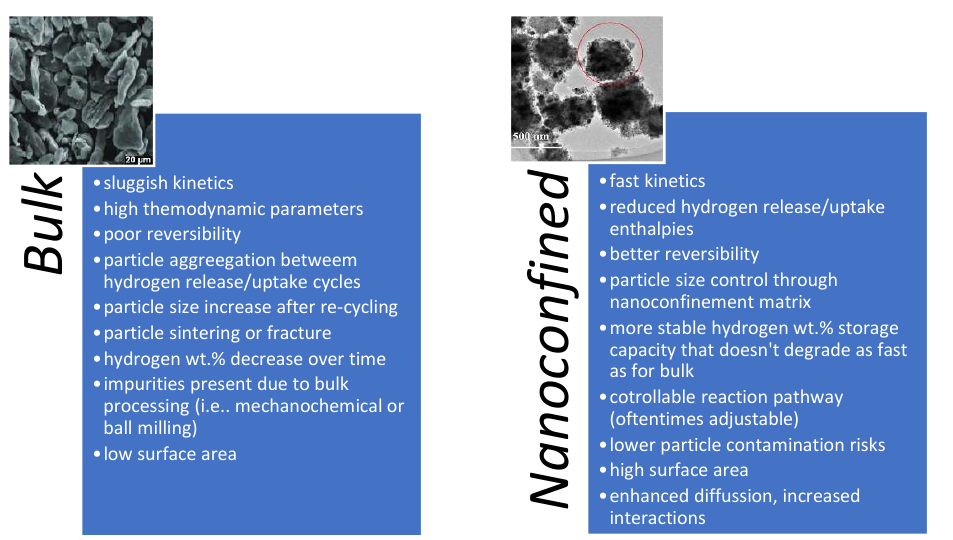
Figure 2. Main features of bulk and nanoconfined materials for hydrogen storage; exemplified for the case of an overly-studied hydride, MgH 2 . (inset reprinted/adapted with permission from Ref. [65]. 2022, Elsevier).